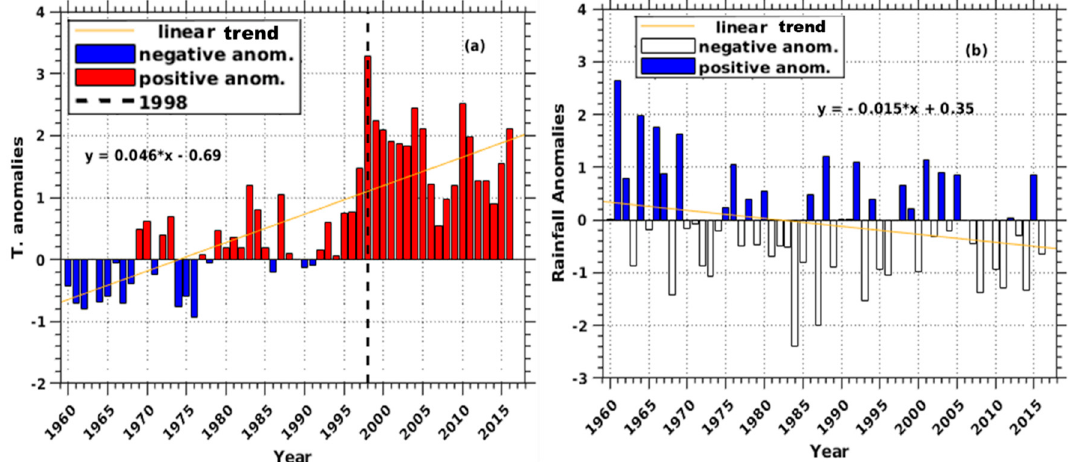
Figure 5. Temperature anomalies with dotted vertical line showing the year 1998, the blue (red) bars are negative (positive) anomalies and the increasing linear trend ( a ). Rainfall anomalies with decreasing linear trend, blue (white) bars indicate positive (negative) anomalies ( b ) of Conakry airport station: 1960–2016.